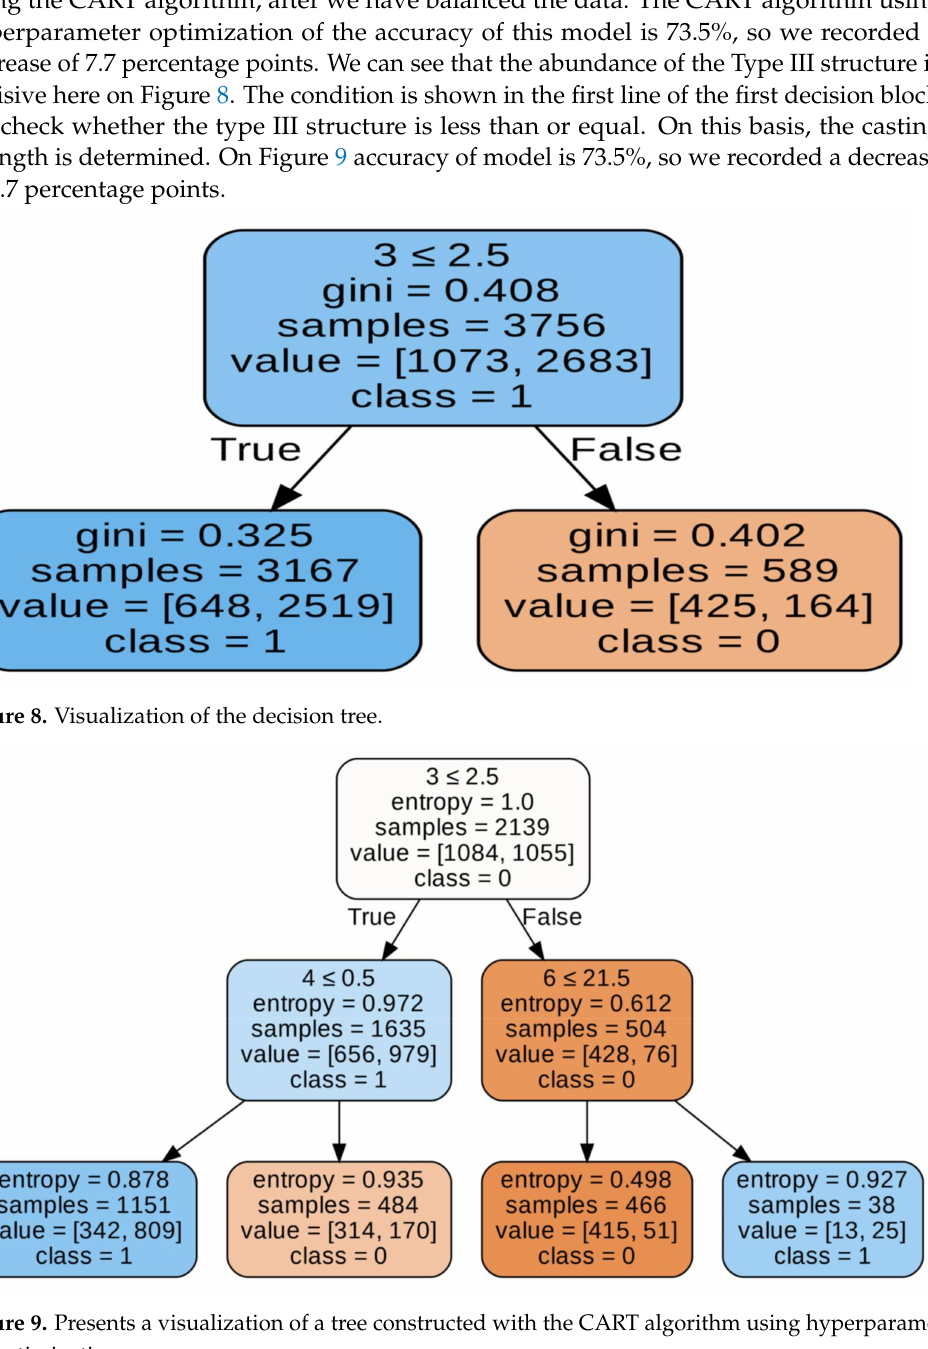
Figure 9. Presents a visualization of a tree constructed with the CART algorithm using hyperparame- ter